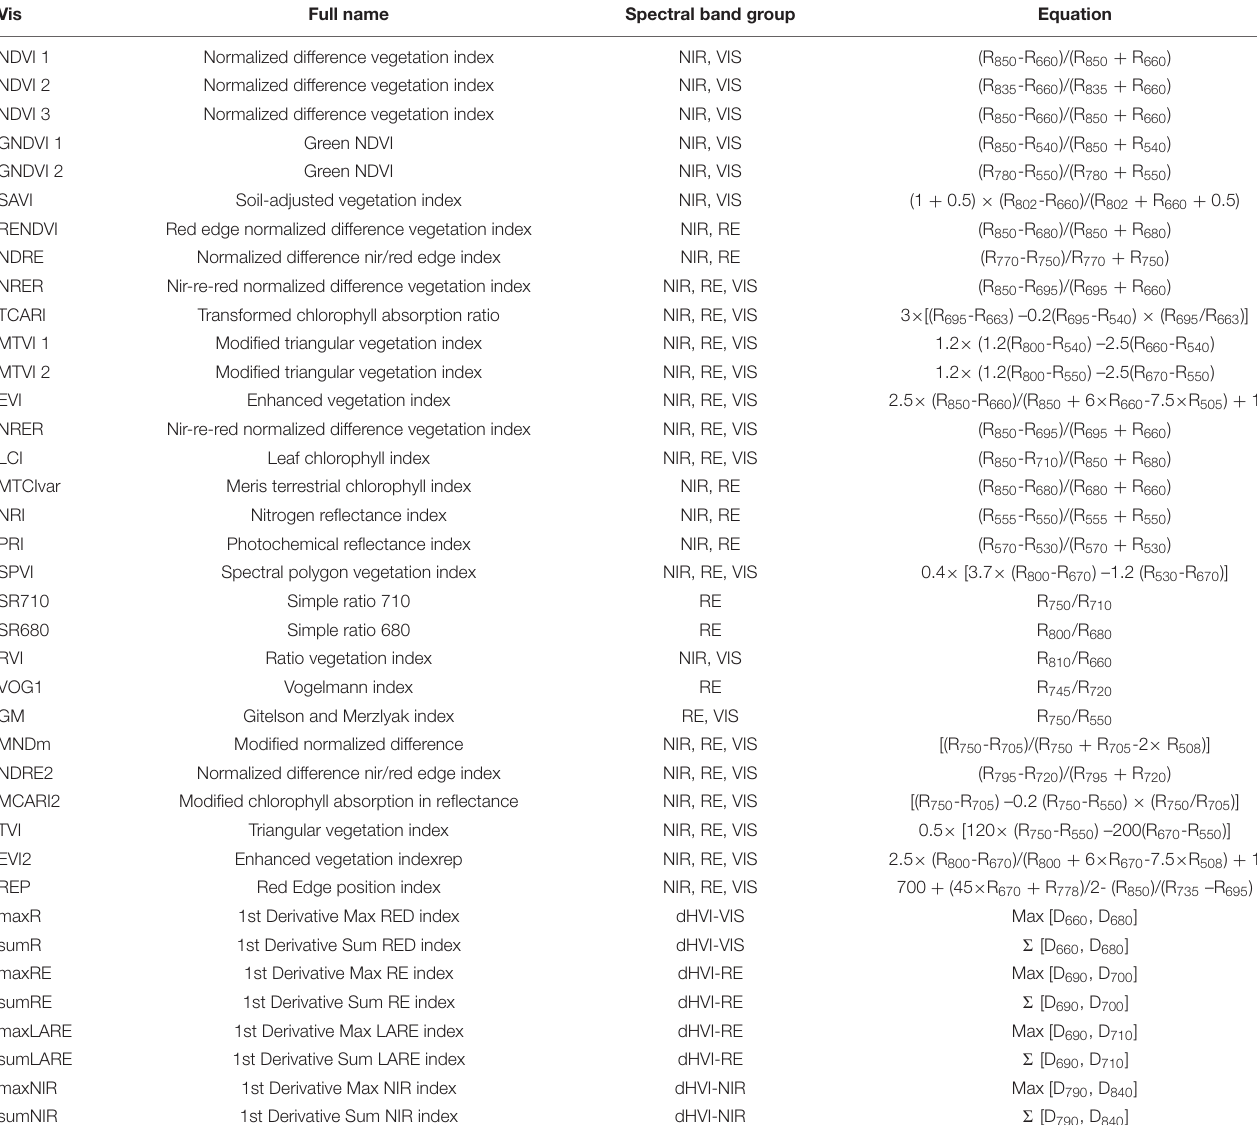
TABLE 1 | Narrowband vegetation indices calculated from HS dataset.